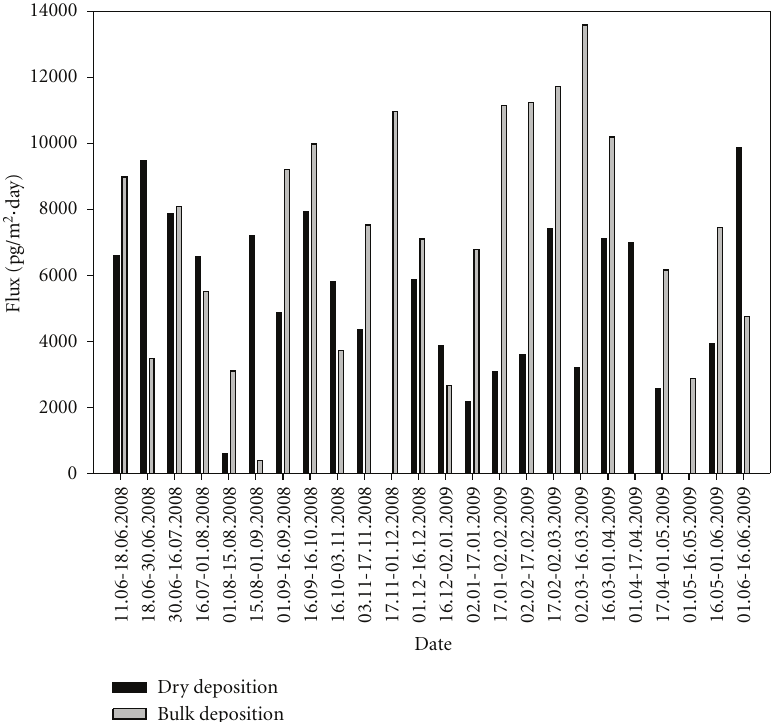
Figure 3: Temporal variation of dry and bulk deposition flux values.